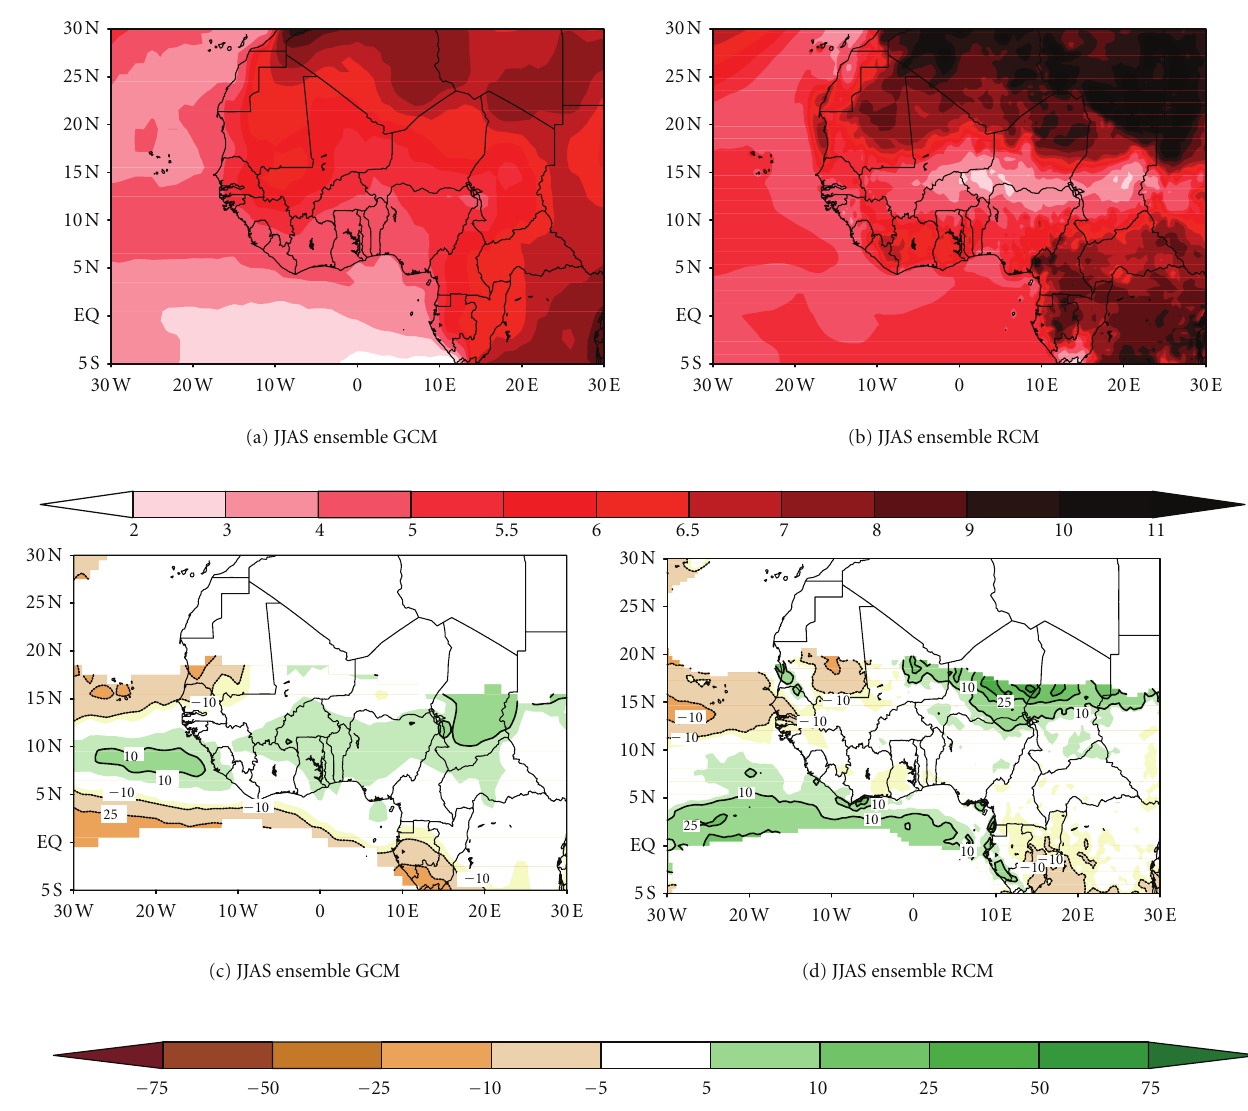
Figure 11: Averaged JJAS di ff erence between the future (A1B: 2031–2050) and the reference period (1981–2000) of temperature (top panel) and precipitation (bottom panel), from: (a and c) mean ensemble average of the two GCMs; (b, d) multi-model ensemble of the four RCMs. Precipitation changes, in % of present day values and where reference means less than 0.5mm/day, are masked out. Contours represent where the changes are significant at 90%